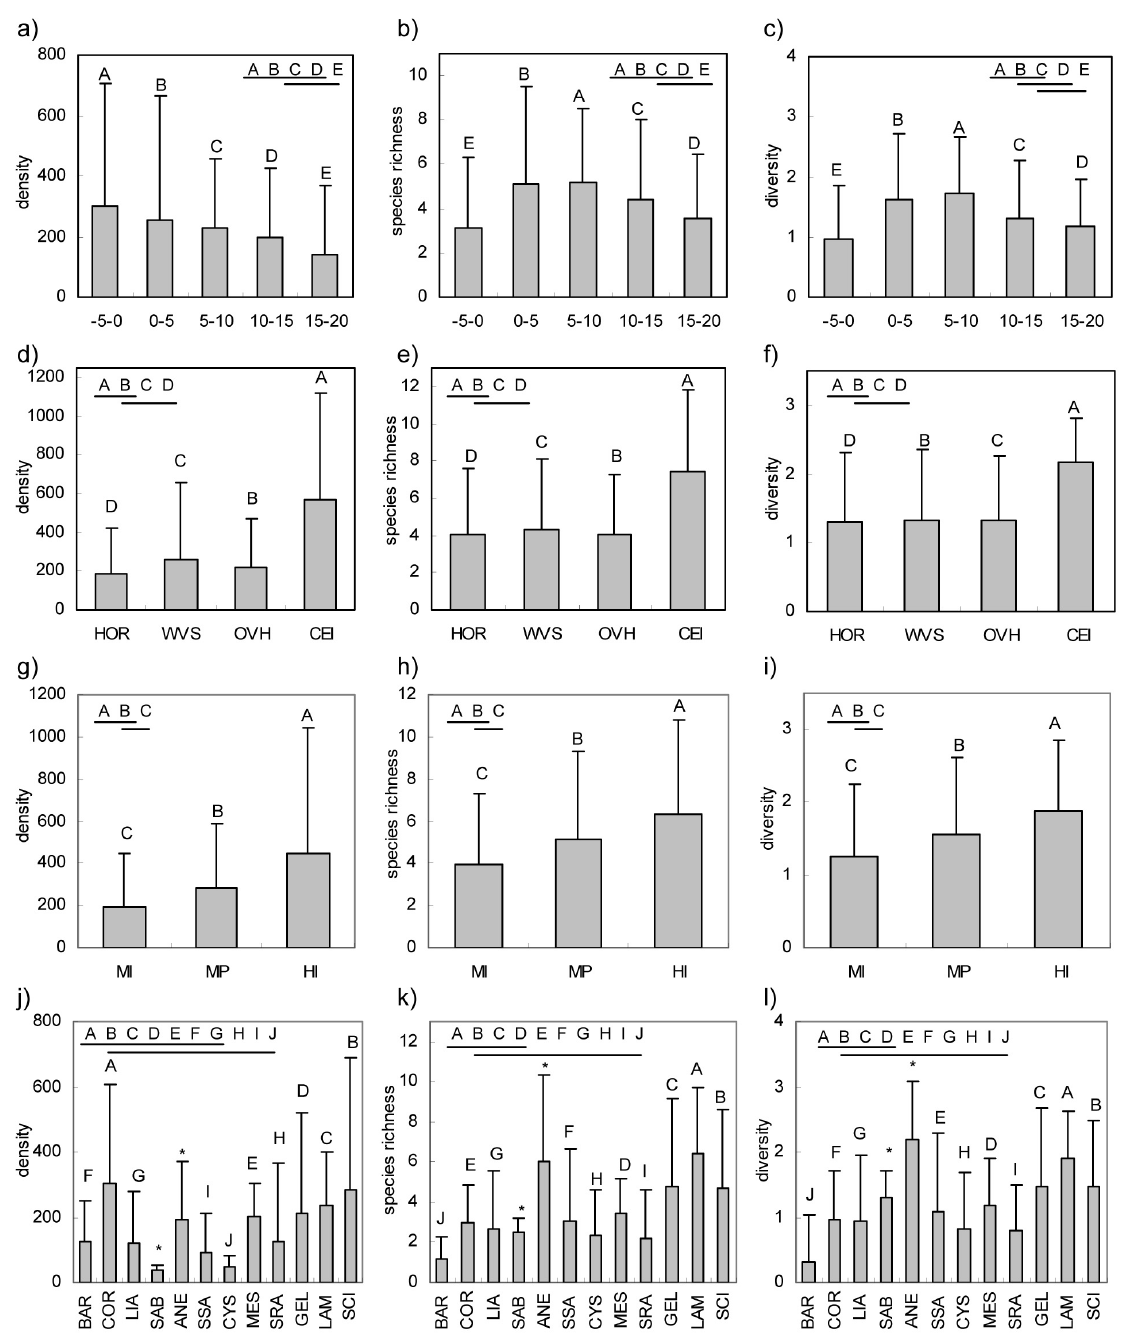
F IG . 2. – Syllid density (ind m -2 ), species richness, and diversity at depth ranges (a, b, c), at semiquantitative levels of substratum inclination (d, e, f), at zone (g, h, i), and habitat (j, k, l). See acronyms in Material and methods section. Uppercase letters indicate mean values arranged in descending order. Groups of underlined letters indicate non-significant differences between pair